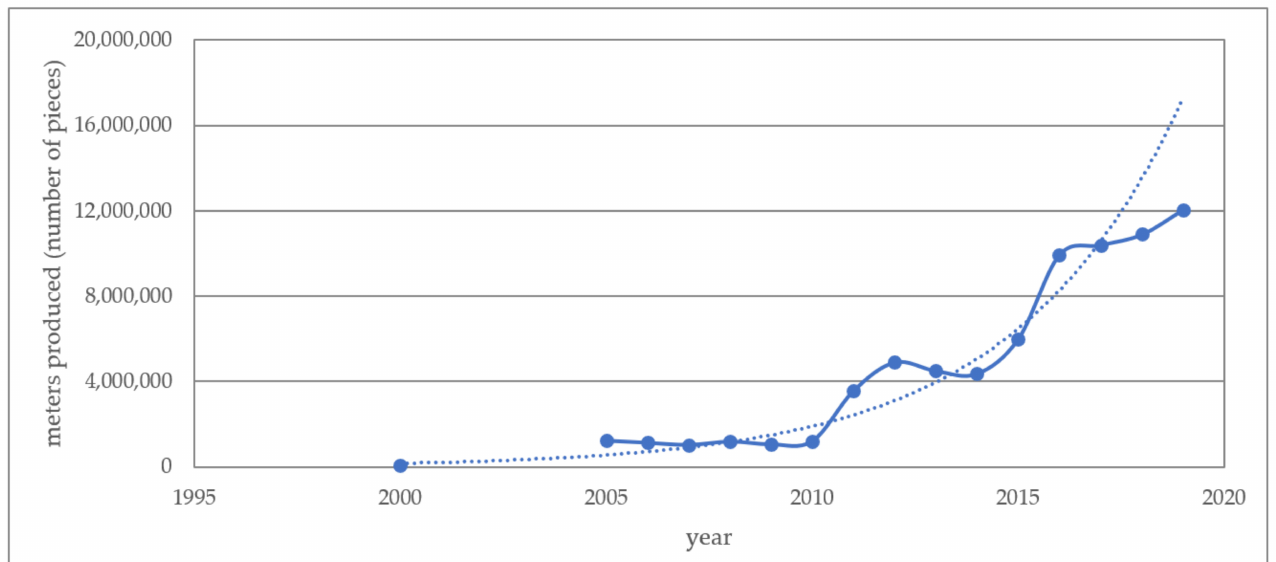
Figure 1. Production of electricity meters (all types, including SMs) in Poland between 2000 and 2019